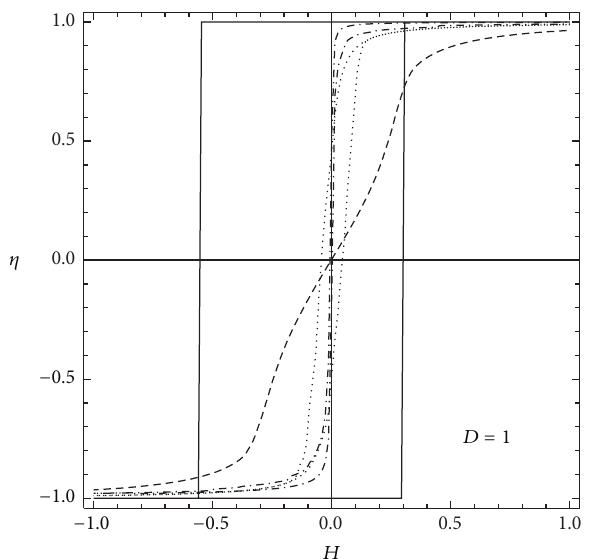
Figure 3: Lattice simulation 𝐷 = 1 : dependence of 𝜂(𝐻) on external field 𝐻 through a complete hysteresis cycle. We observe either (a) 𝜇 = 4 (dashed line), no hysteresis; (b) 𝜇 = 0.05 (rectangularly shaped), single loop hysteresis; (c) 𝜇 = 0.15 (dash-dotted line), double loop hysteresis; or (d) 𝜇 = 2 , S-shaped single loop